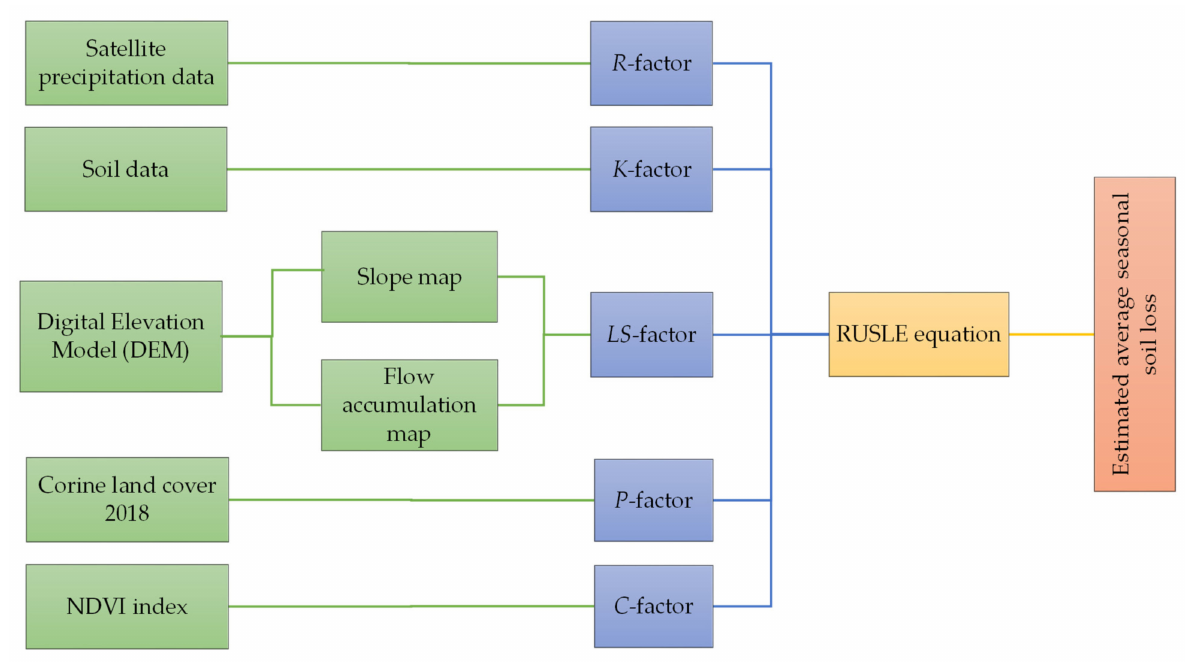
Figure 6. Flowchart for the average soil loss estimation using the RUSLE